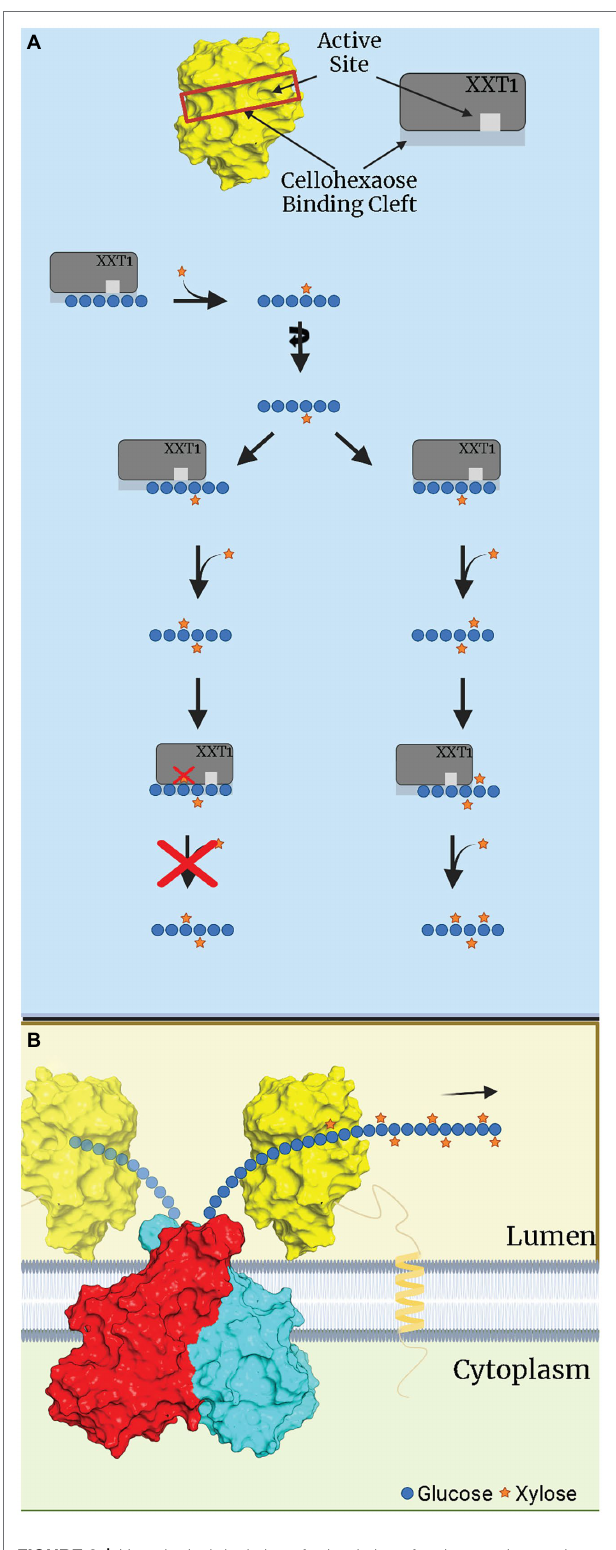
FIGURE 2 | Hypothetical depiction of xylosylation of a glucan substrate by XXT1. (A) In vitro xylosylation of cellohexaose by XXT1. XXT1 mono- and